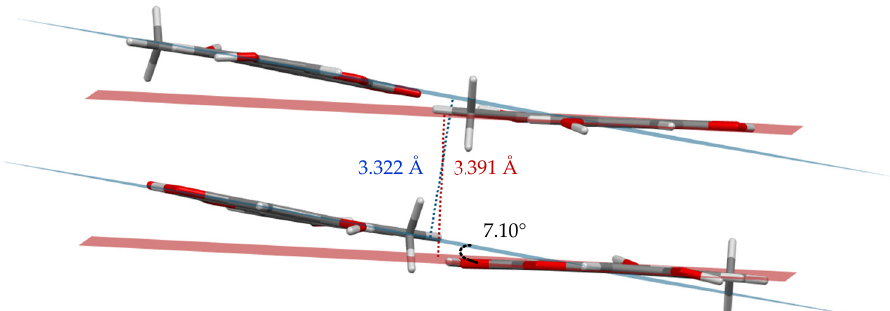
Figure 3. Perspective view depicting the interlayer distance and dihedral angle between best fit planes for two pairs of π -stacked molecules.